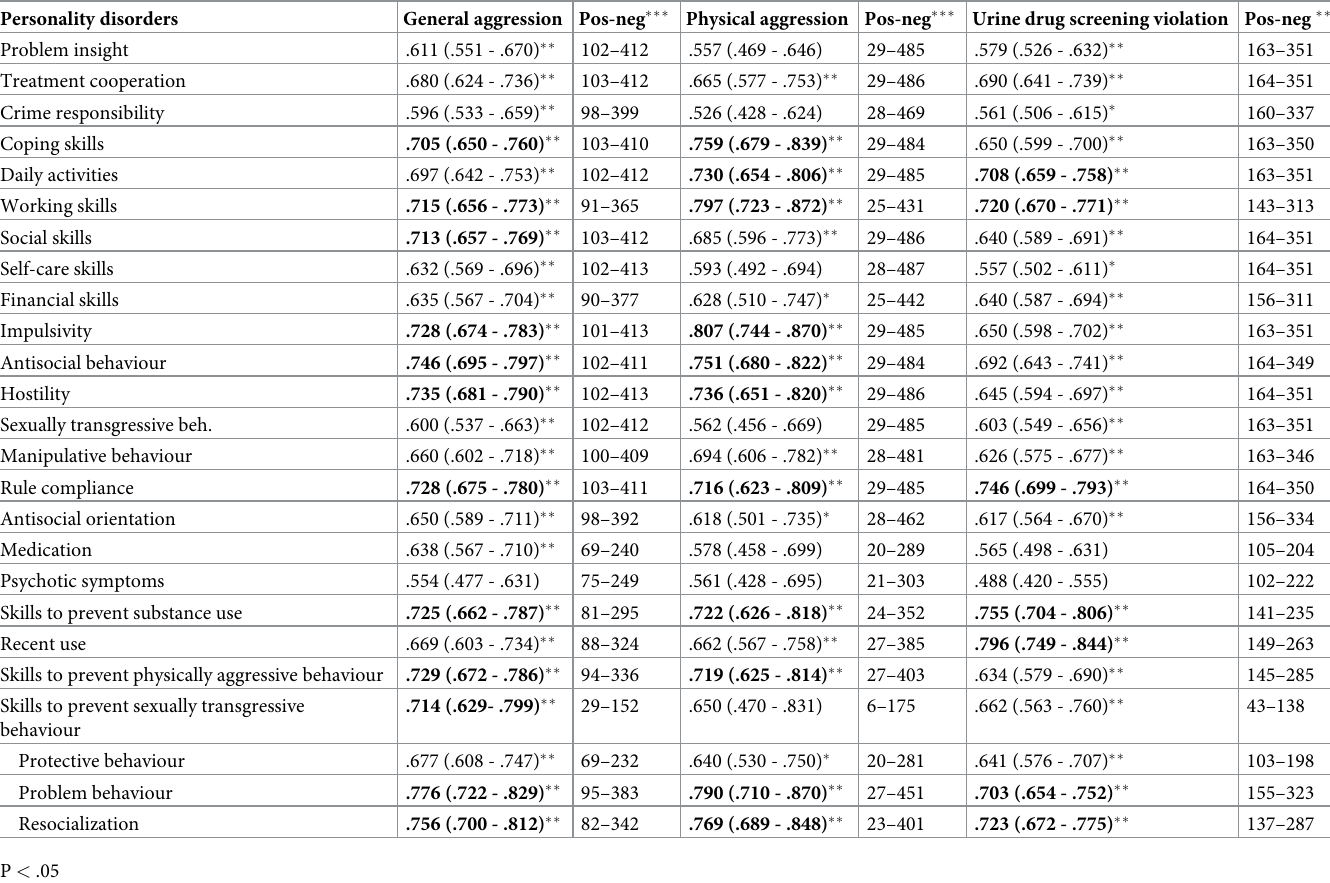
Table 5. AUCs for the personality disordered group.